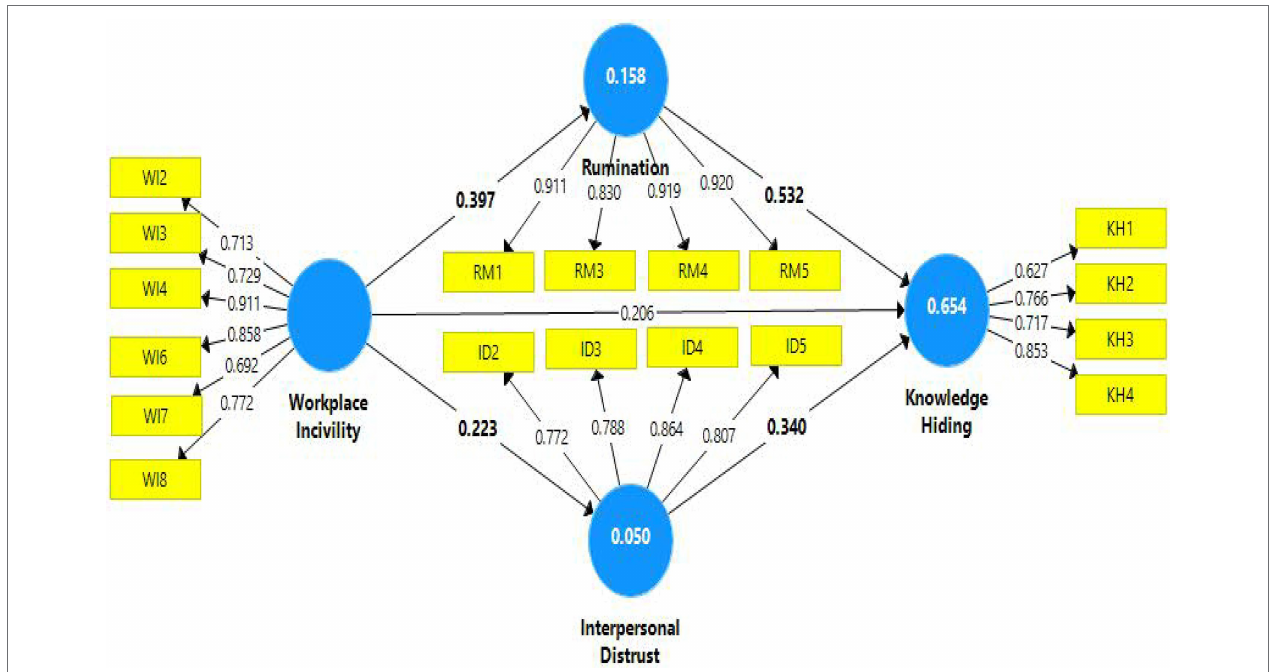
FIGURE 1 | Path diagram.